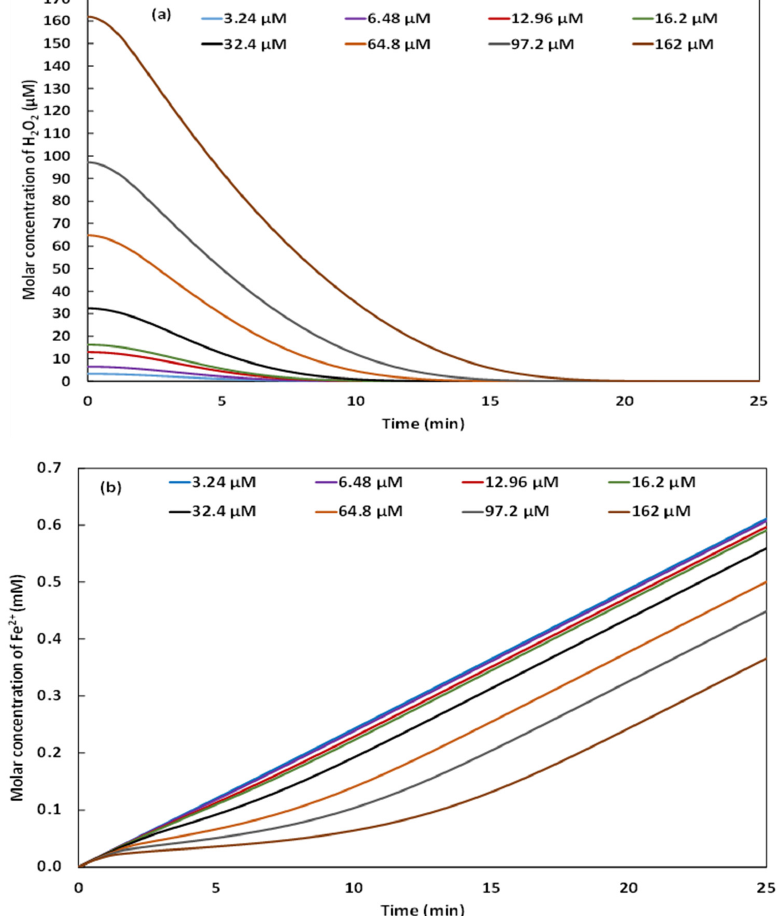
Figure 7. Simulated kinetics of H (cid:2870) O (cid:2870) consumption ( a ) and Fe (cid:2870)(cid:2878) generation ( b ) in the electrolyte with different concen- trations of added hydrogen peroxide (pH 3 and initial concentration of NBB: 5 mg ⋅ L − 1